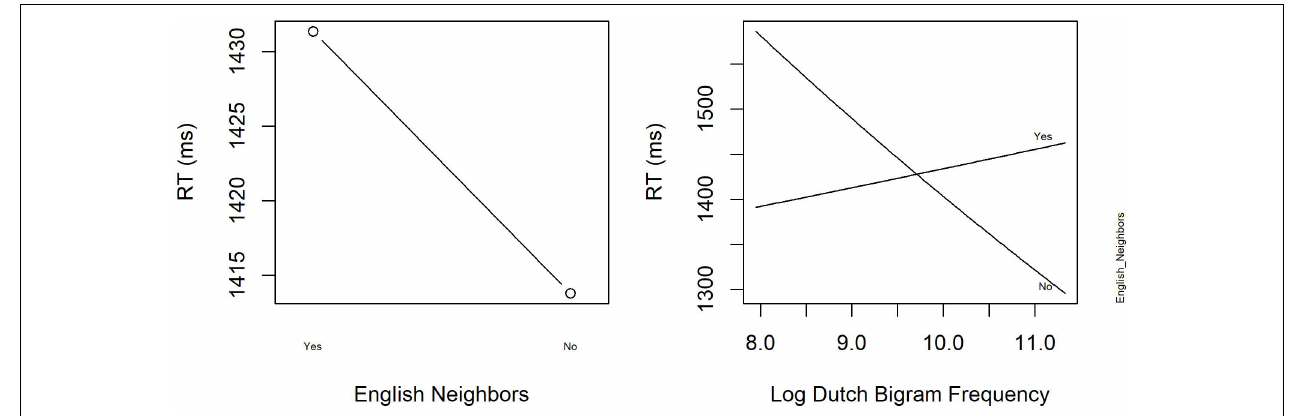
FIGURE 4 | The significant main effect of English Neighbors and the interaction between English Neighbors and Log Dutch Bigram Frequency in English Progressive Demasking with hermits (Experiment